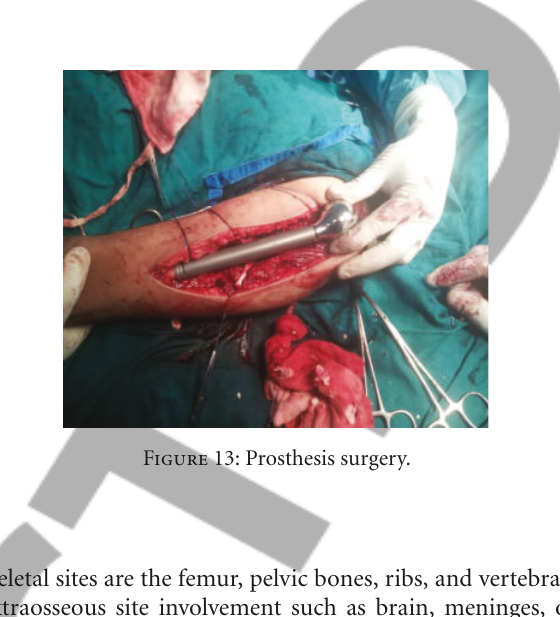
Figure 13: Prosthesis